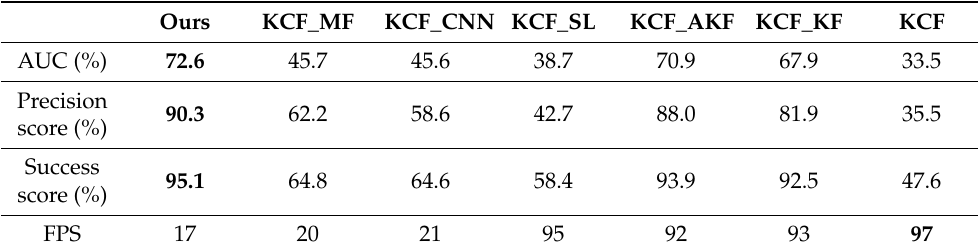
Table 3. The experimental ablation results of all occluded video sequences (in bold the optimal results per tracker).